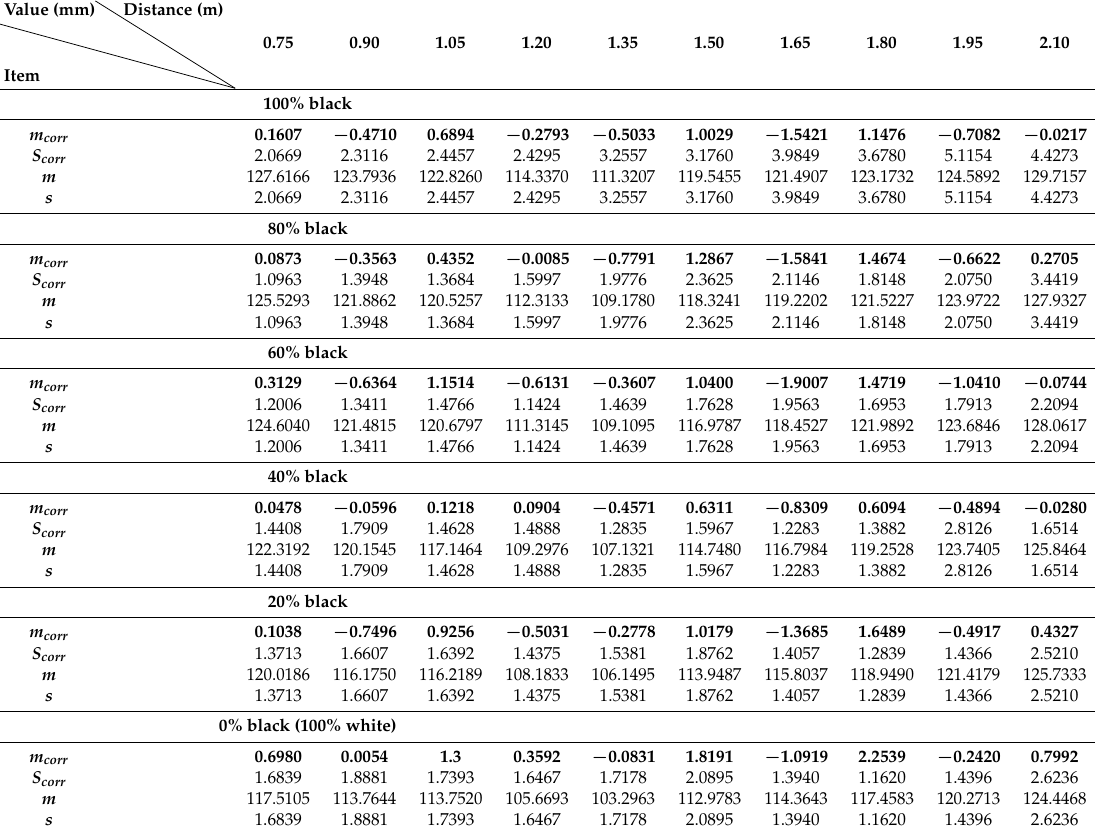
Table 4. Expectation and standard deviation of correction and uncorrection at different reflectivity.